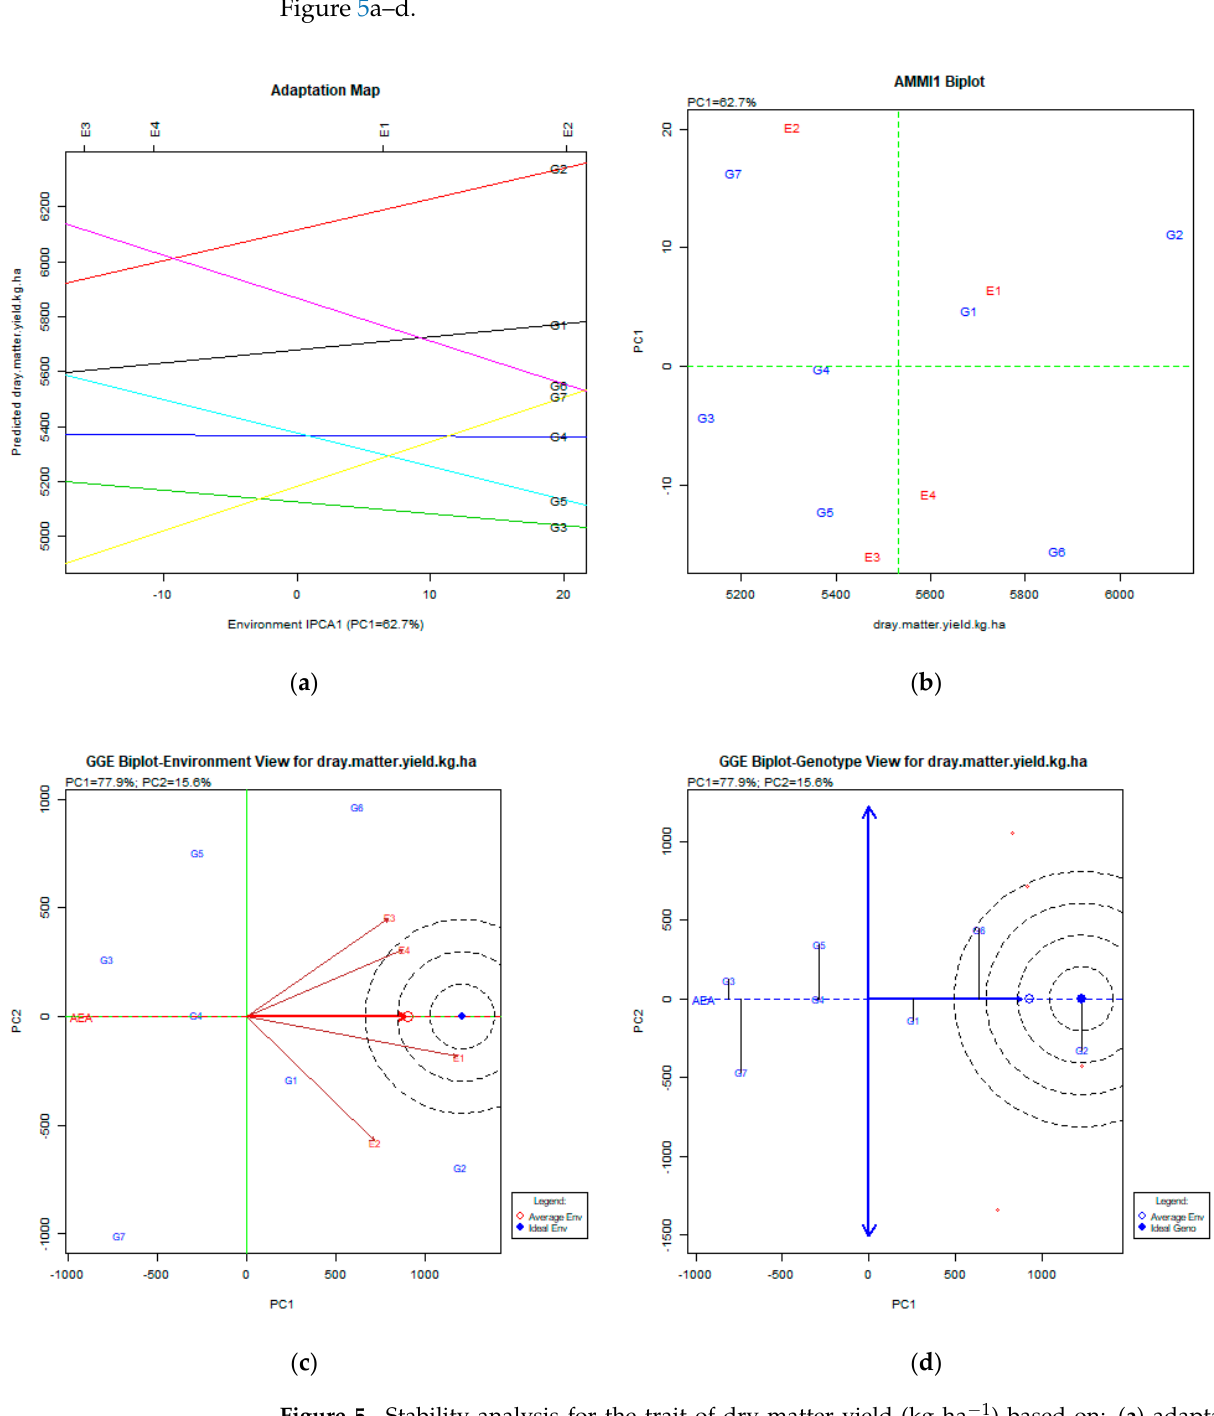
Figure 5. Stability analysis for the trait of dry matter yield (kg ha − 1 ) based on: ( a ) adaptation map, where the environmental stability of the genotypes is visualized by the X -axis (PC1) and the performance of the trait for the genotypes is tested by the Y -axis; ( b ) AMMI1 biplot, where the environmental stability of the genotypes is visualized by the X -axis (PC1) and the performance of the trait for the genotypes is tested by the Y -axis; ( c ) GGE biplot depicting the environmental stability over time for the desirable genotypes placed near to ideal environment; ( d ) GGE biplot for genotypes depicting the genotypic stability in different environments. The desirable genotypes are those placed near the concentric region of the ideal genotype.